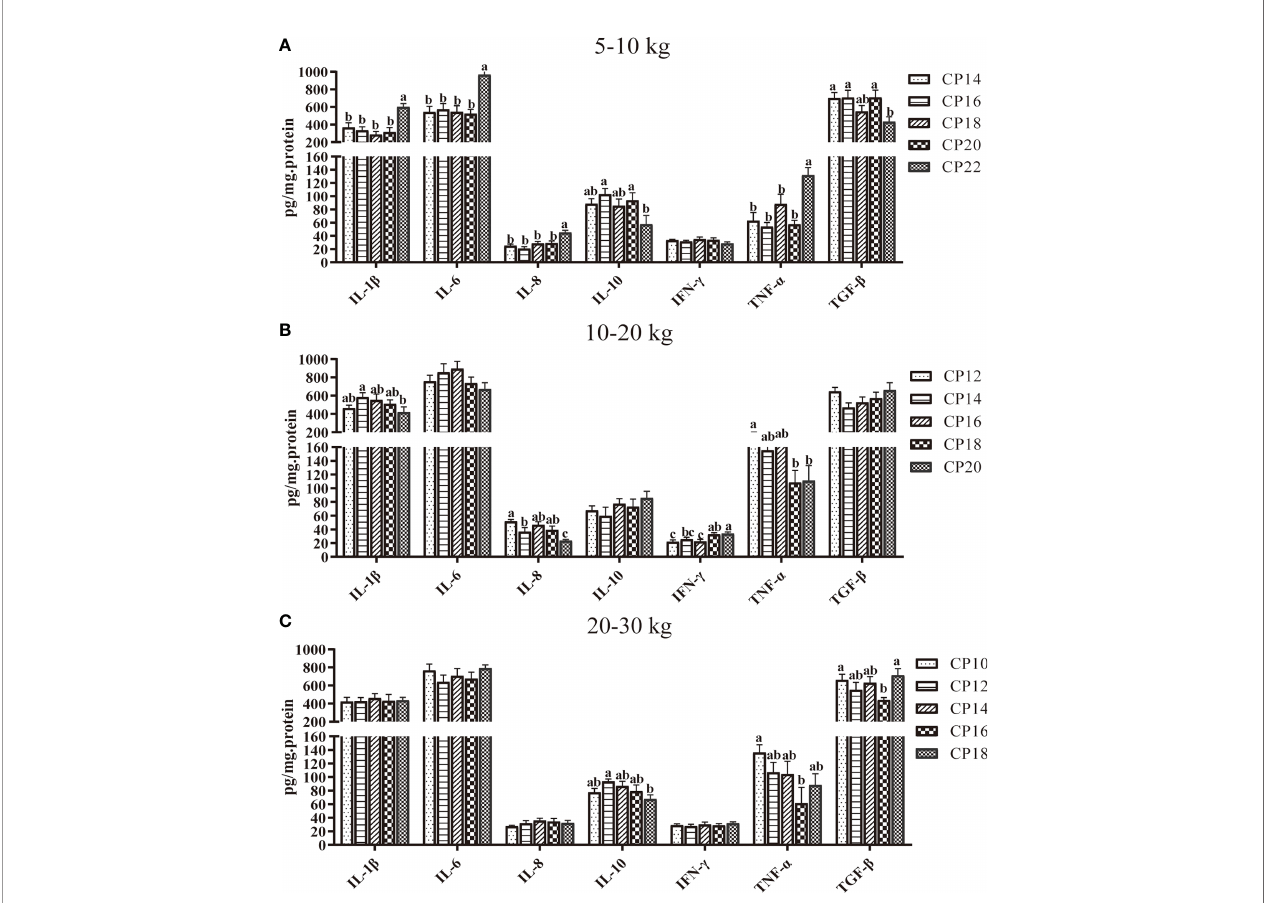
FIGURE 3 | Effects of dietary crude protein (CP) levels on the plasma cytokine concentrations of Huanjiang mini-pigs during 5 − 10 kg (A) , 10 − 20 kg (B) , and 20 − 30 kg (C) growth stages. Data are presented as means ± SE ( n = 6 − 8 per group). Different superscript letters indicate signi fi cant differences among the fi ve groups ( P < 0.05). IL, interleukin; IFN, interferon; TNF- a , tumor necrosis factor-alpha; TGF- b , transforming growth